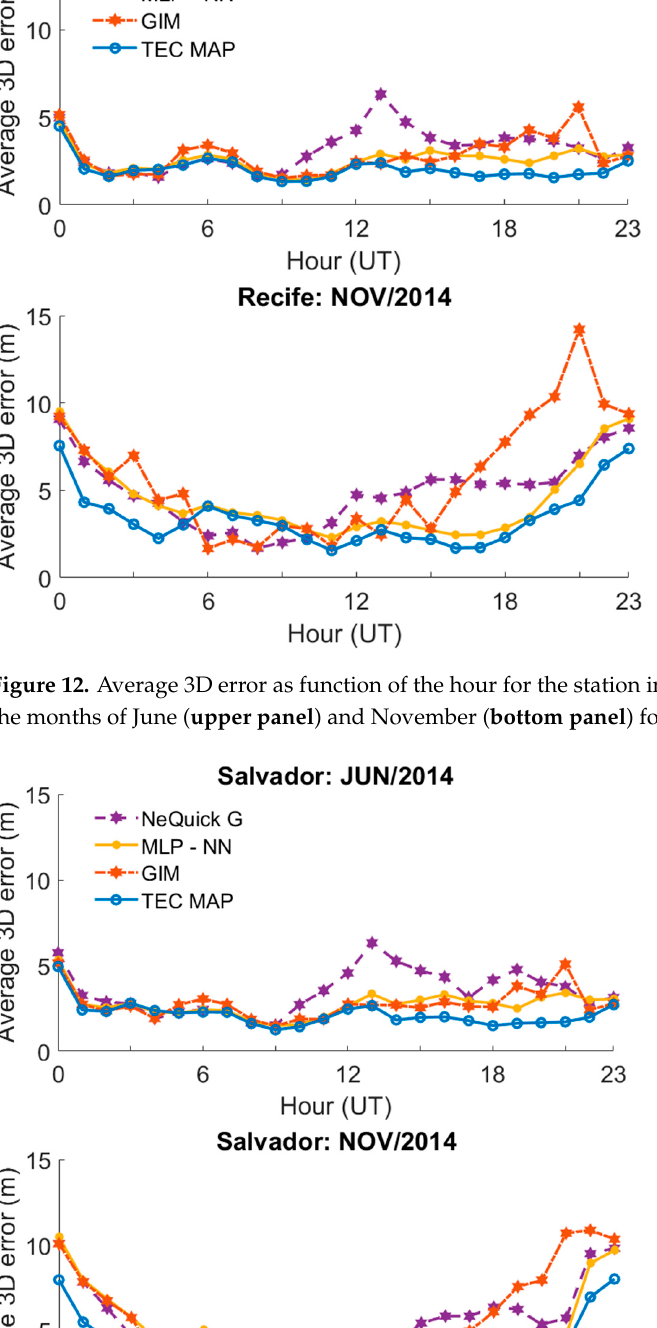
Table 4. Average and standard deviation for 3D error during the months of June and November in Recife and Salvador during 2014. 3D Error